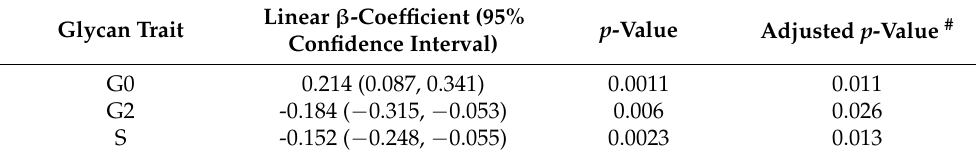
Linear β -Coefficient